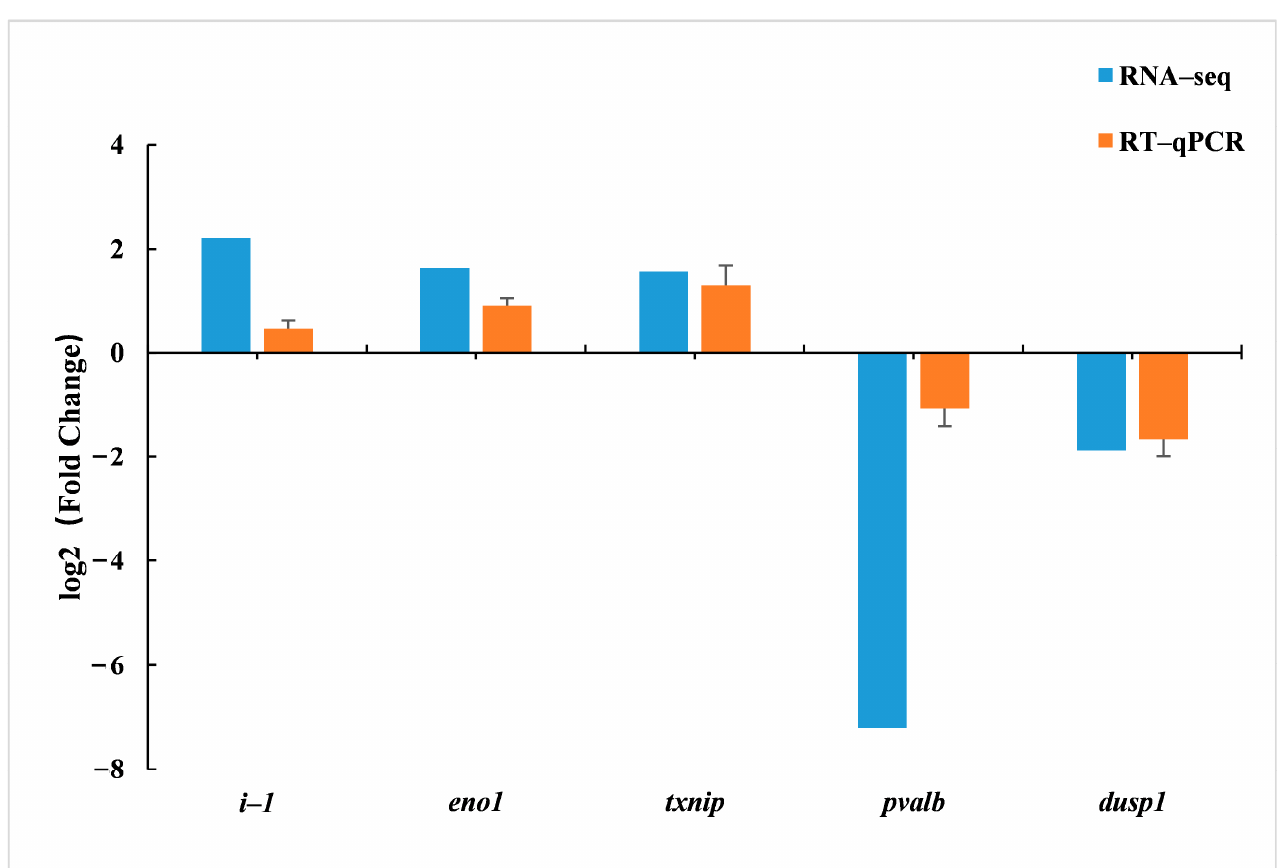
Figure 6. RT-qPCR verification of DEGs in the livers of juvenile hybrid groupers (SL0 vs L3).